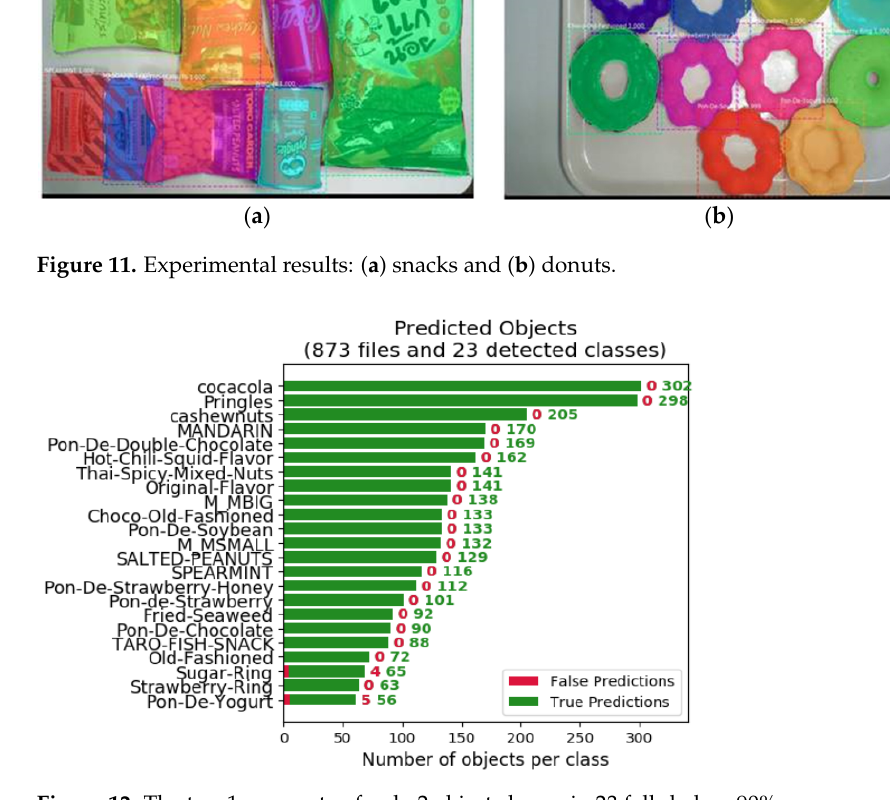
Table 6. Comparison of ACT and mAP for each algorithm.